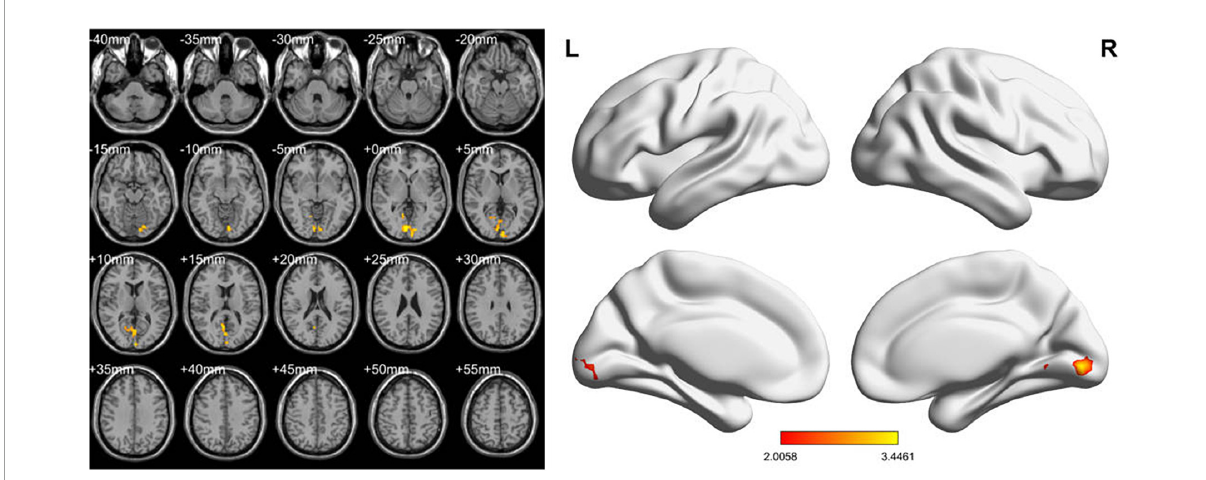
FIGURE2 ALFF values using two-sample t -tests in the conventional band between LDH-pre patients and HCs. Increased ALFF values have been shown in the right lingual gyri in LDH-pre group compared with HCs. (GRF correction, voxel p < 0.05 and cluster p < 0.05). Color bar indicates the t score (L, left; R,